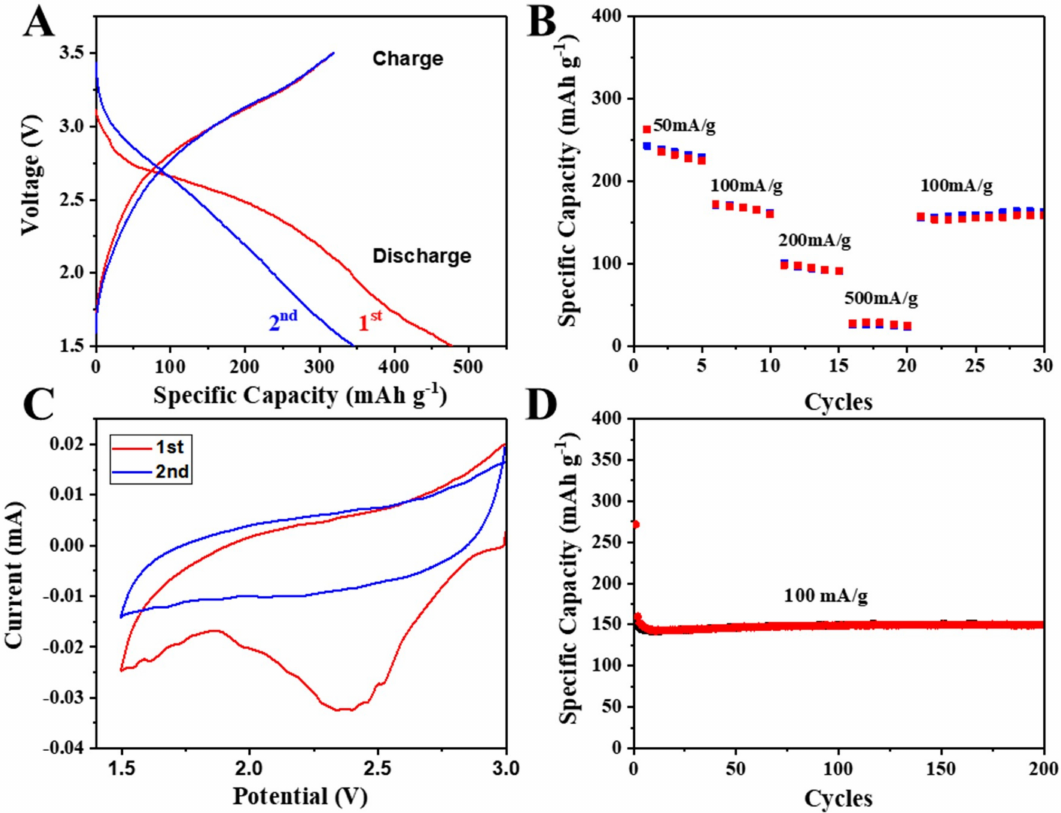
Figure 5. Electrochemical data of α -MnO 2 cathode electrode. ( A ) charge-discharge profile, ( B ) rate study, ( C ) cyclic voltammetry curve, and ( D ) long cycle study at current density of 100 mA g − 1